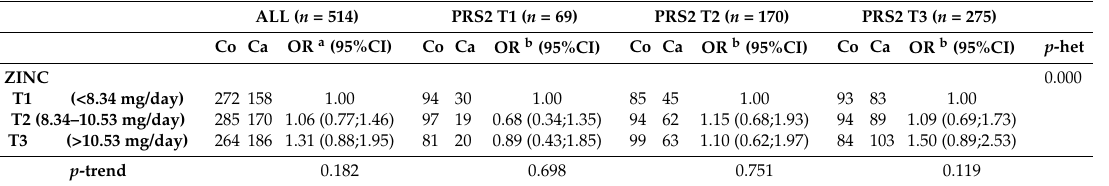
Table 4. Association between dietary zinc and prostate cancer by genetic susceptibility to prostate cancer, measured with tertiles of the polygenic risk score